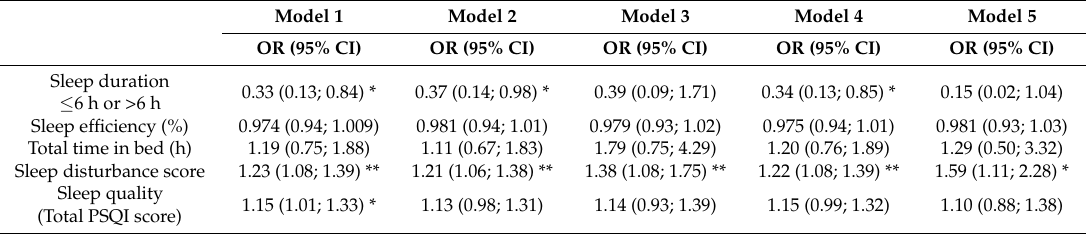
Association between sleep characteristics and risk for hepatic steatosis assessed by ultrasonography in NAFLD patients ( n = 94) and controls ( n =